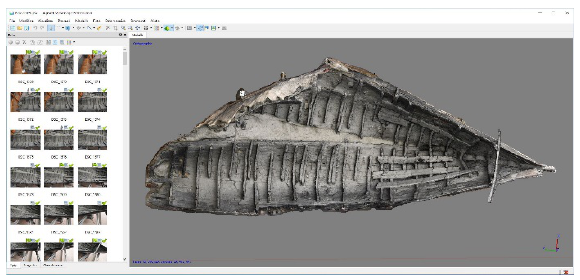
Figure 4. Screenshot of the mesh obtained from the photogrammetric acquisition (Elaboration with Agisoft Metashape